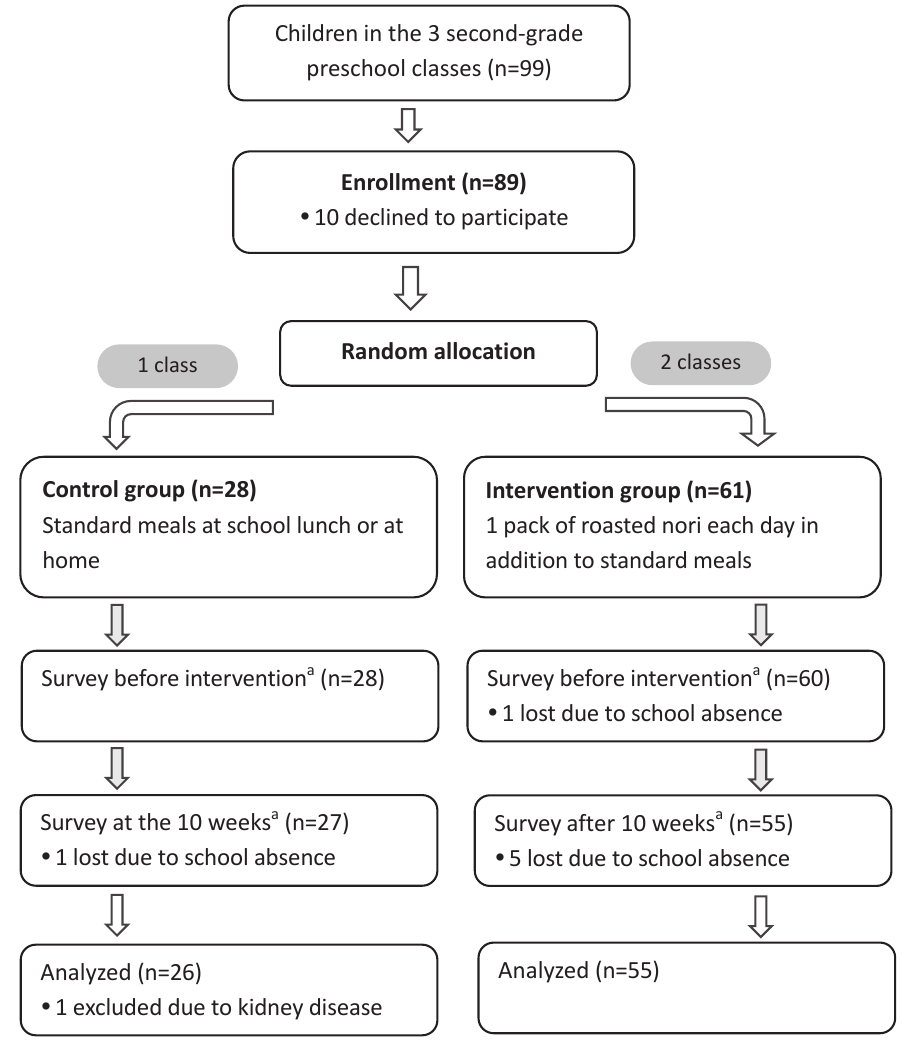
Figure 1. Flow diagram of